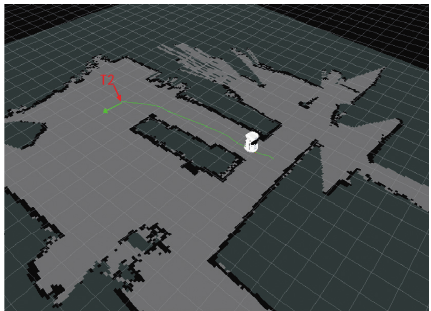
Figure 7: Path-planning response of T2 in